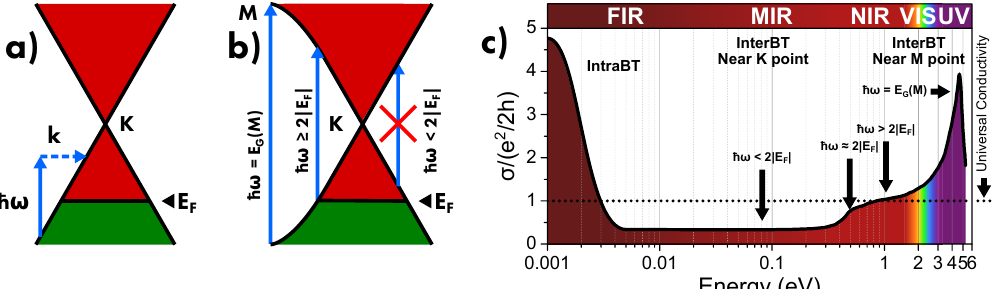
Figure 11. ( a ) Diagram of intraband light absorption transitions at the K point of graphene Brillouin zone. In particular, absorption of photons at various energies ( (cid:125) ω , continuous arrows), and phonon and defect-assisted scattering ( k , dashed arrows) are depicted. ( b ) Diagram of interband light absorption transitions at the K and M points. In particular, absorption of photons at various energies ( (cid:125) ω ), for allowed and forbidden transitions are depicted. Adapted with permission from Ref. [22]. Copyright (2012) Elsevier. ( c ) Light absorption of graphene in the far-infrared (FIR), mid-infrared (MIR), near-infrared (NIR), visible (VIS) regions due to intraband and interband transitions at the K point. The effect of non-null graphene Fermi Energy determines the enhancement of absorption in the FIR region and the quenching in the MIR due to oscillator-strength sum rule and Pauli blocking, respectively. The absorption band in VIS-UV region due to the transition at M point is also